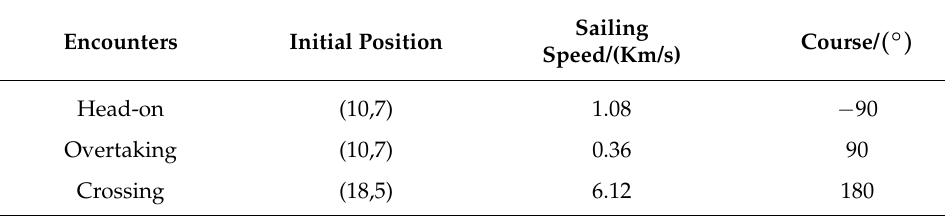
Table 4. Initial parameters of the obstacle for different encounter situations.